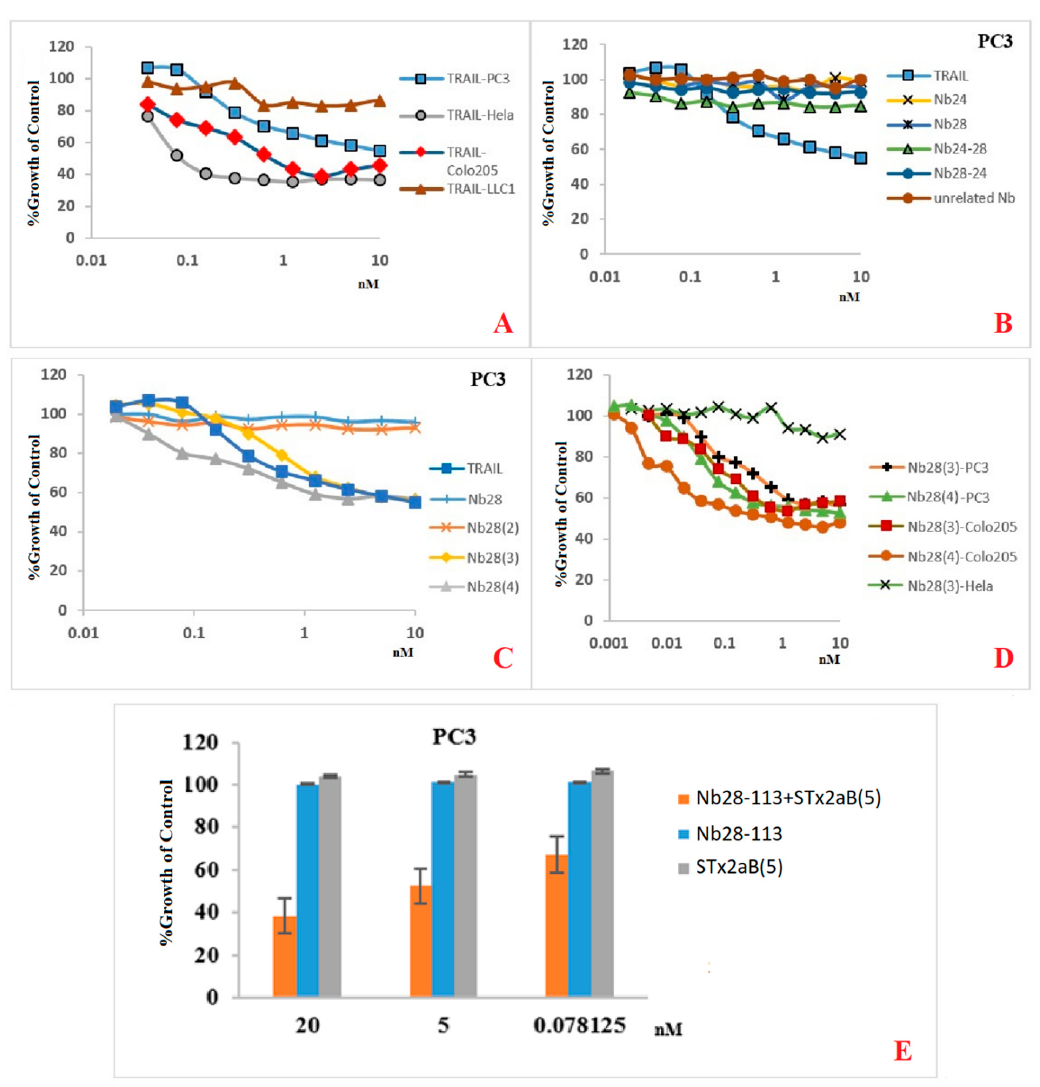
Figure 4. Survival of several cancer cell lines upon challenge with TRAIL or Nb constructs. ( A ) human cancer cell lines Colo205, HeLa, or PC3 or mouse cancer cell line LLC1 were exposed to human TRAIL at various concentrations and the % growth of non-treated control was measured. ( B ) The e ff ect of TRAIL or monovalent Nb24 or Nb28, or biparatopic Nb28-24 or Nb24-28 at di ff erent concentrations on PC3 cells was followed. ( C ) The % growth of control for PC3 cells when exposed to various concentrations of TRAIL, or monovalent, bivalent or trivalent Nb28. ( D ) The % of growth of cancer cells relative to control cells was measured for PC3, Colo205, or HeLa cell when exposed to various concentrations of trivalent or tetravalent Nb28. ( E ) The growth of PC3 cells challenged with Stx2aB pentamer, with Nb28-113 or the mixture of both at three di ff erent